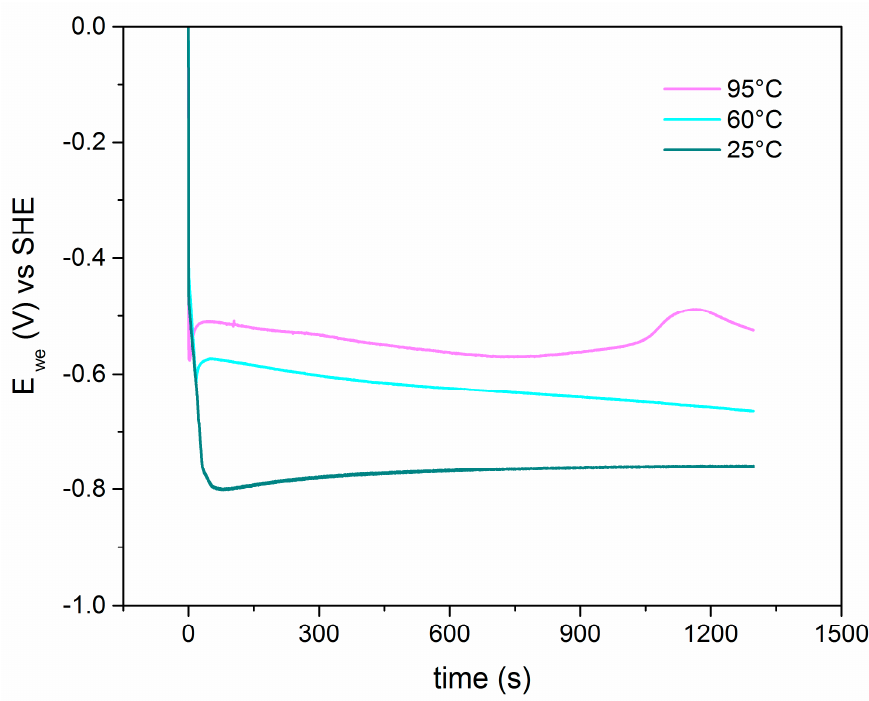
Figure 1. Electrodeposit chronopotentiograms plots at different temperatures in 0.1 M Co(NO 3 ) 2 .